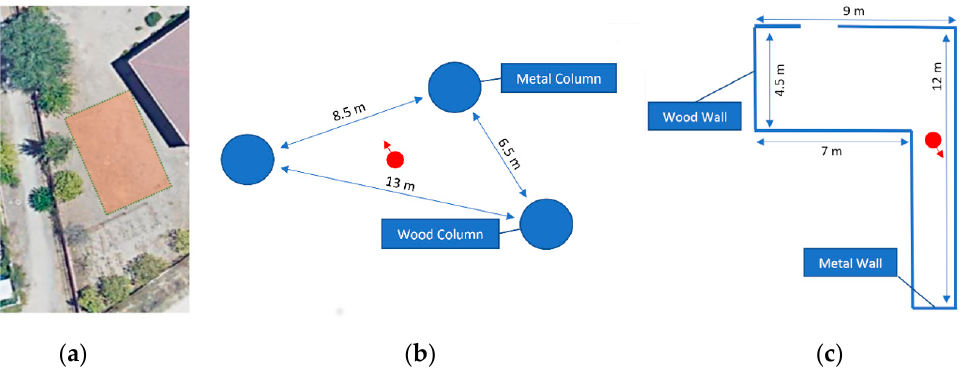
Figure 7. Testing field ( a ). Virtual environment of the first ( b ) and second ( c ) tests. The starting position and orientation are represented by a red dot and arrow.